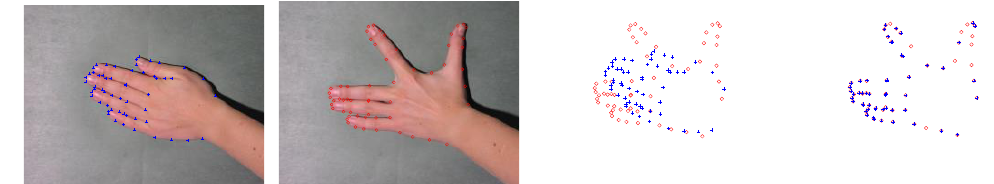
Figure 9. A failure case in Group 4 of IMM hands dataset. From left to right: the model image, the scene image, the original point sets, and the registration results. The model point sets are marked by “ +, ” and the scene point sets are marked by “ o. ”